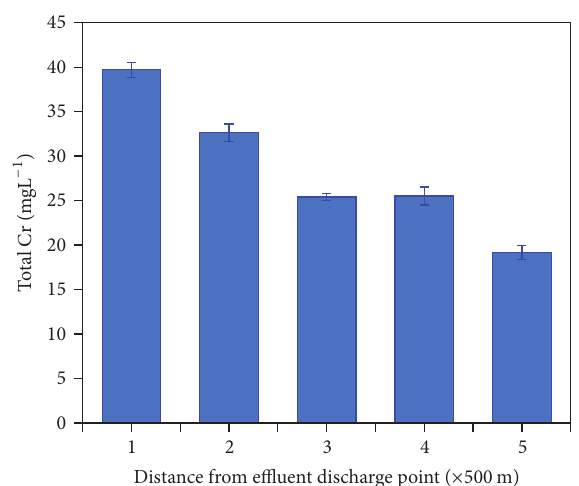
Figure 3: Mean values and standard deviations of total Cr con- centrations recorded in soil samples collected 10m away from the wastewater channel and at different distances from the tannery effluent discharge